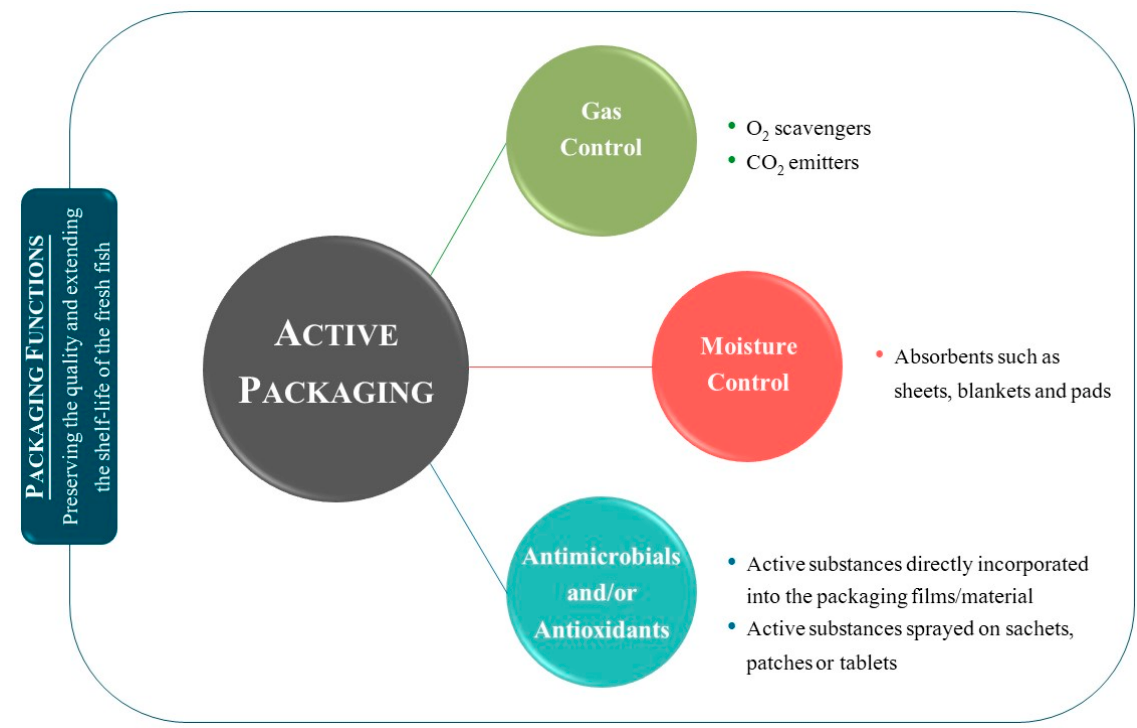
Figure 3. Active packaging technology applied to fishery products. Based on information available in [17].